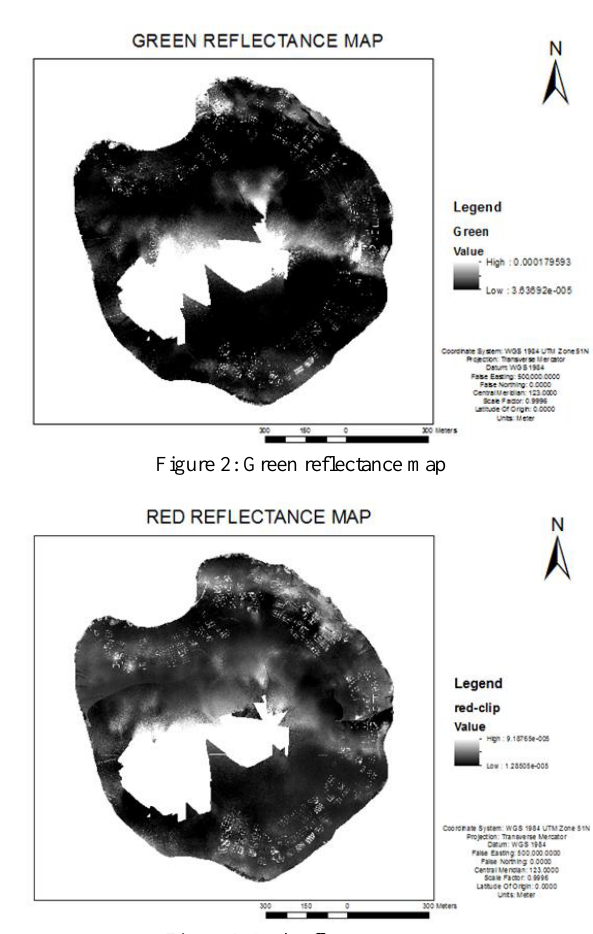
Figure 3. Red reflectance map